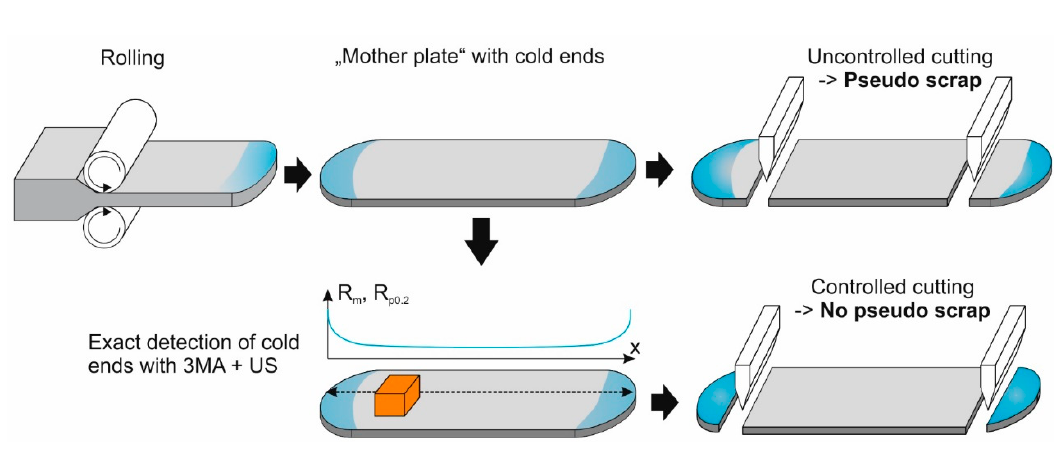
Figure 16. Avoiding pseudo ‐ scrap by precise detection of the extension of cold ends.